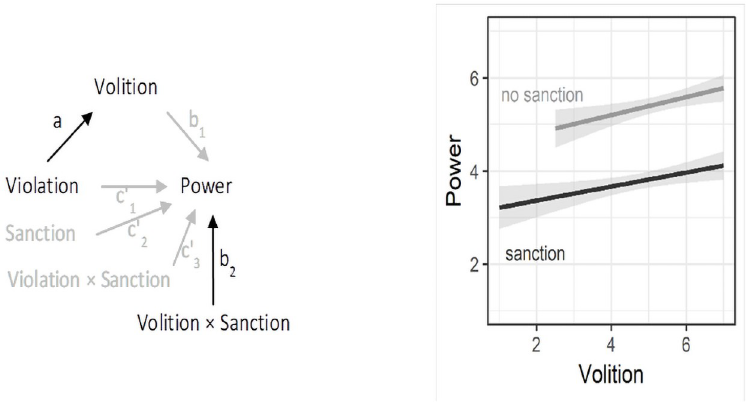
Fig 4. Statistical model (left) of the proposed moderating effect of sanctioning in Study 1. Black arrows in the statistical model highlight relevant effects for moderated mediation (ab 2 ). Simple slopes with standard errors (right) illustrate b 2 , the lack of an interaction of volition and sanctions on power